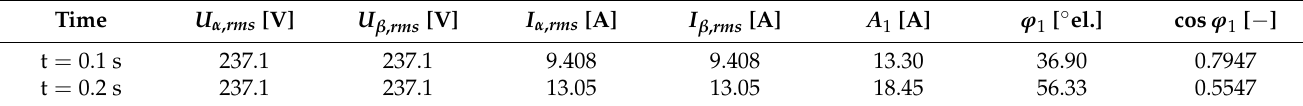
Table 31. Simulation results before and after the change (at steady